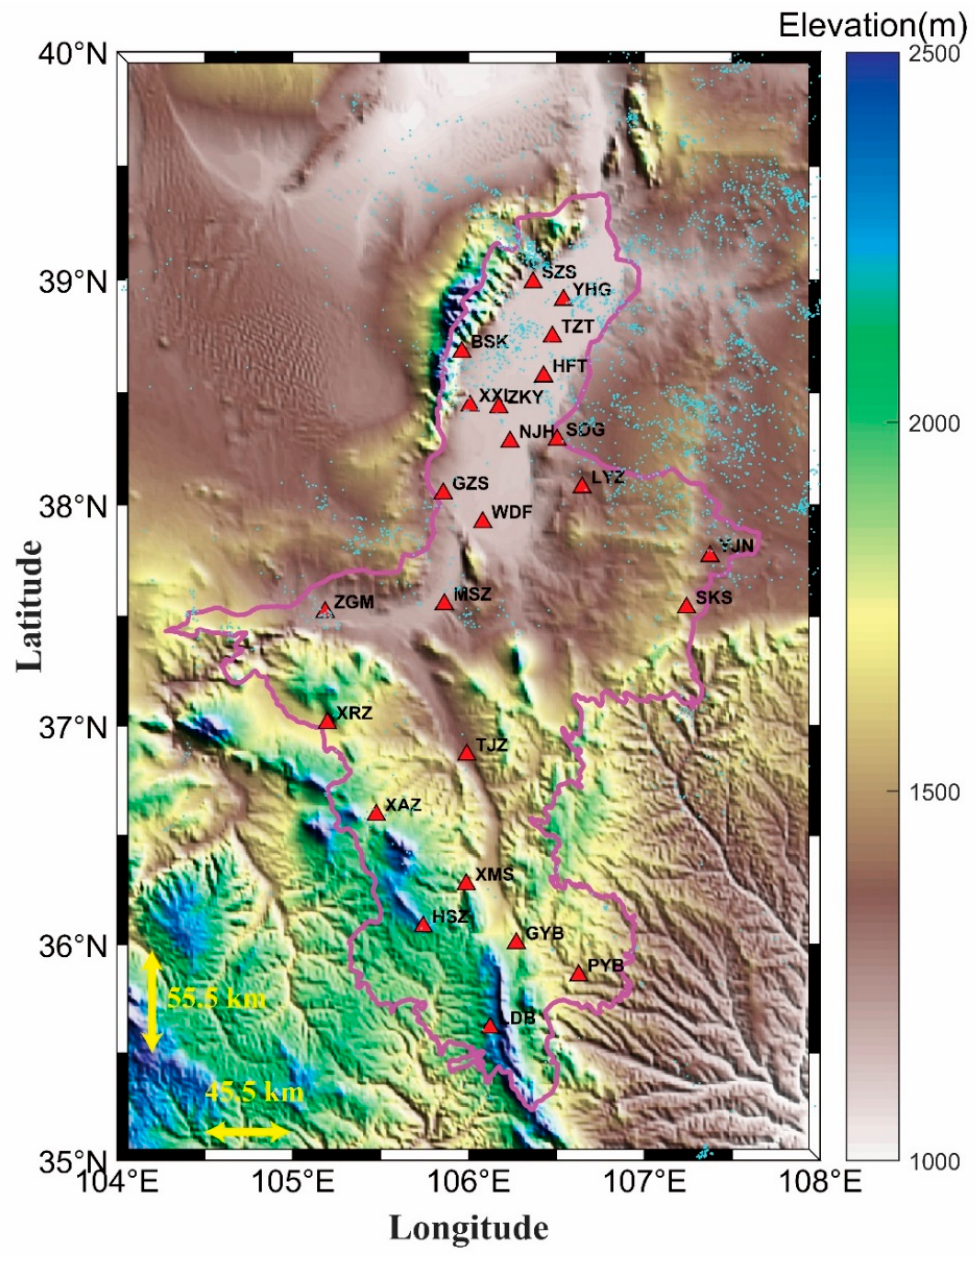
Figure 1. Geographical locations of the Ningxia FALMA sites with the filling color representing the elevation above sea level. The cyan scattered points represent the RS events that were used to estimate the conversion coefficients in Section 3.2.